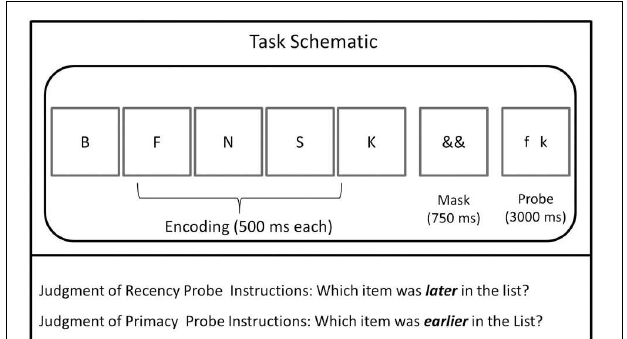
FIGURE 1 | Schematic of the tasks from Experiments 1 and 2. The JOR and JOP tasks employed identical timing and stimuli but differed in whether participants were instructions to report the later or earlier of the two items in the